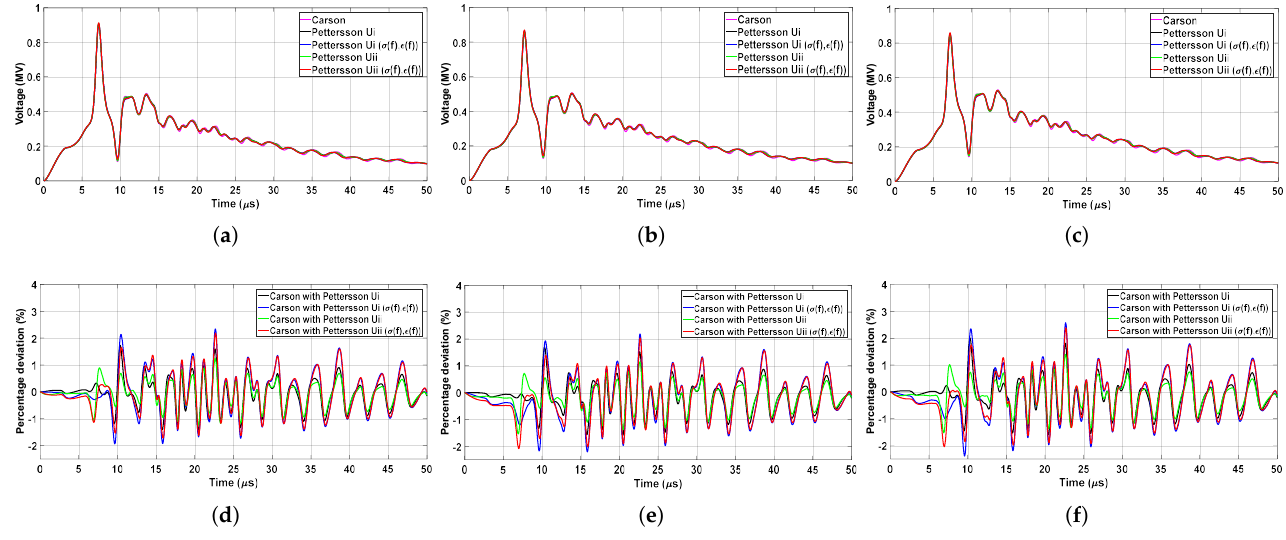
Figure 12. Overvoltage waveforms in phases A ( a ), B ( b ) and C ( c ) and percentage differences, based on Carson’s formulation, for phases A ( d ), B ( e ) and C ( f ), considering ground resistivity equal to 1000 Ω .m and a lightning stroke current waveform with α =